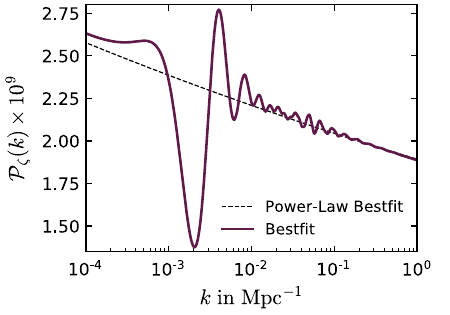
Fig. 1 A birdseye example of background trajectory in our model, plotted over equipotential surfaces (redder means lower potential). In terms of the Cartesian coordinates x and y shown here, for x < 0 the (cid:4) and σ are Cartesian with x = (cid:4) − ((cid:4) T + (cid:4) 0 ) and y = σ + ξ − 1 ; while for x > 0theybecomeradialcoordinatesasin[37,38]with r = σ + ξ − 1 and θ = π/ 2 − ξ((cid:4) − (cid:4) 0 − (cid:4) T ) . The insets show how the inflaton overshoots the bottom of the valley (yellow line) and climbs onto a side of the cliff [top-right], and the clock oscillation [bottom-left]